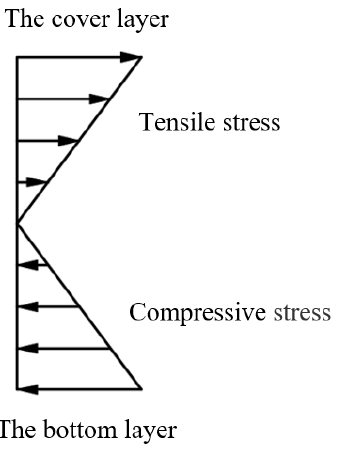
Figure 8. Face bend cross-sectional stress diagram .